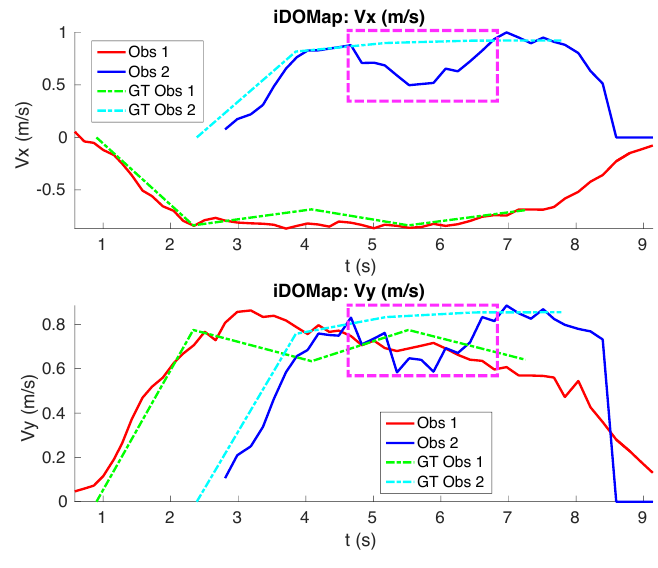
Figure 16. Real scenario 2—Detected velocities.